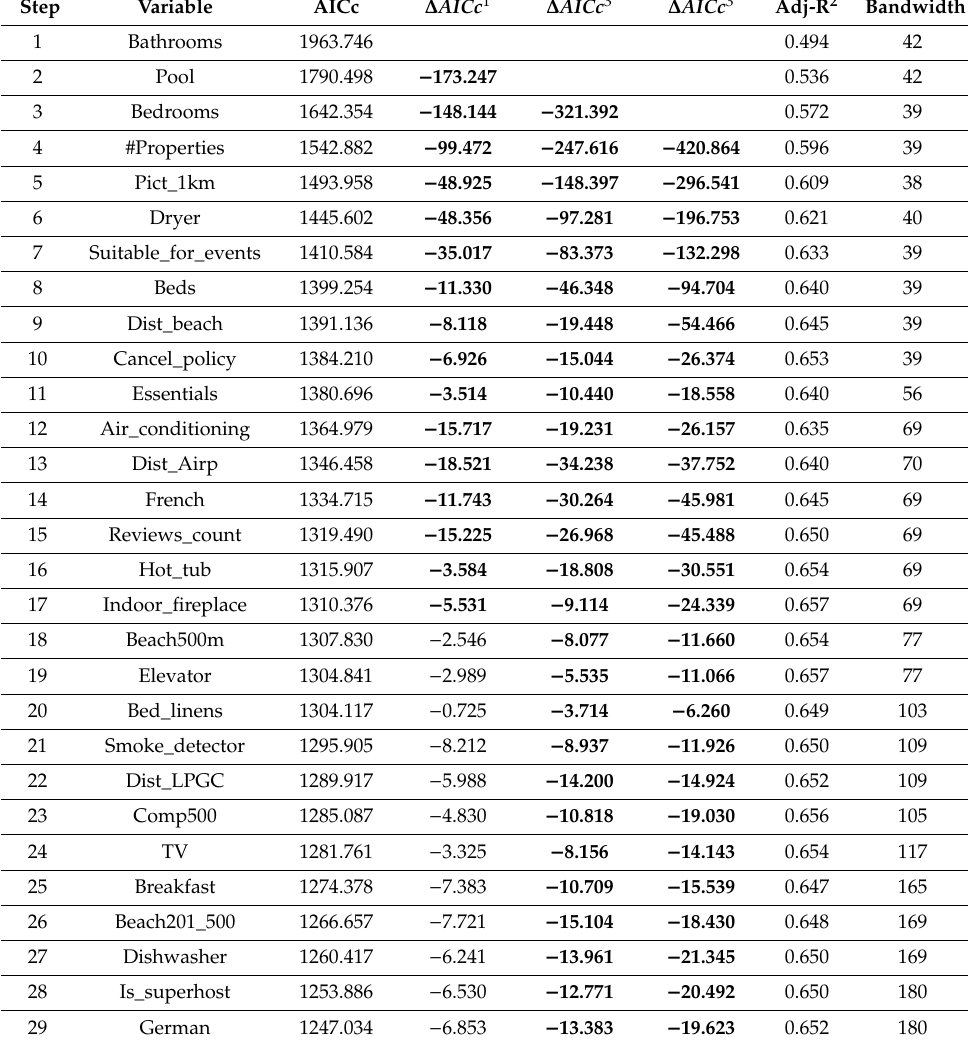
Table 2. SW-GWR step-by-step